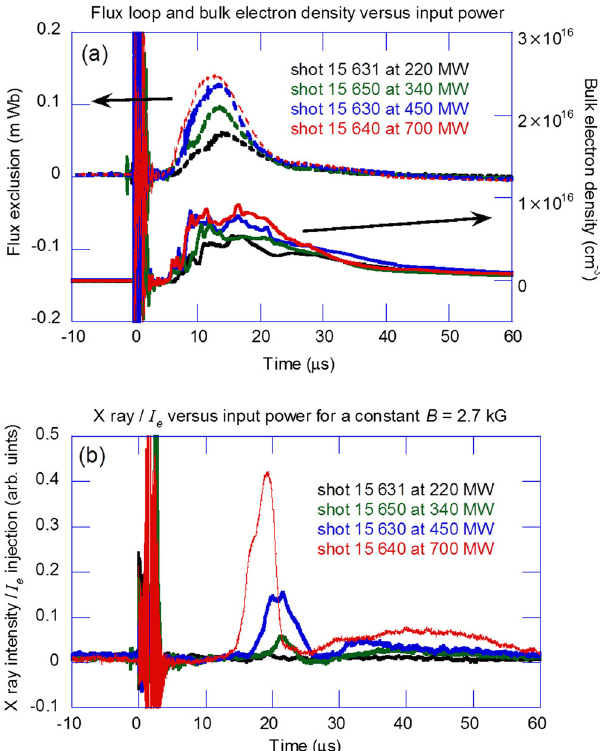
FIG. 6. Plasma parameters as a function of magnetic field at 700 MW injection power: (a) flux exclusion and bulk electron density, (b) normalized x-ray emission